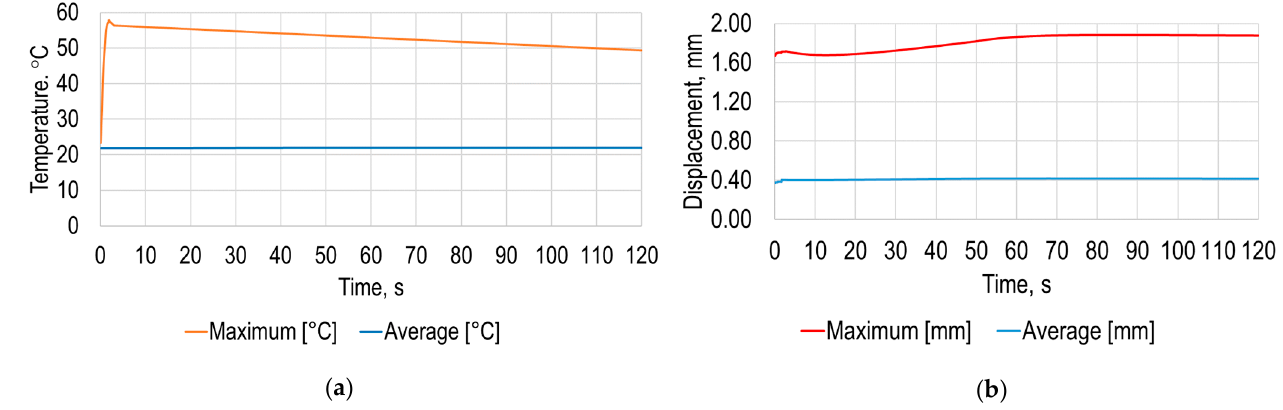
Figure 12. Modeling results: ( a ) average and maximum temperatures of the opposite to the heating polymer sheet surface; ( b ) average and maximum deformation under the earth gravity versus time of the polymer sheet.